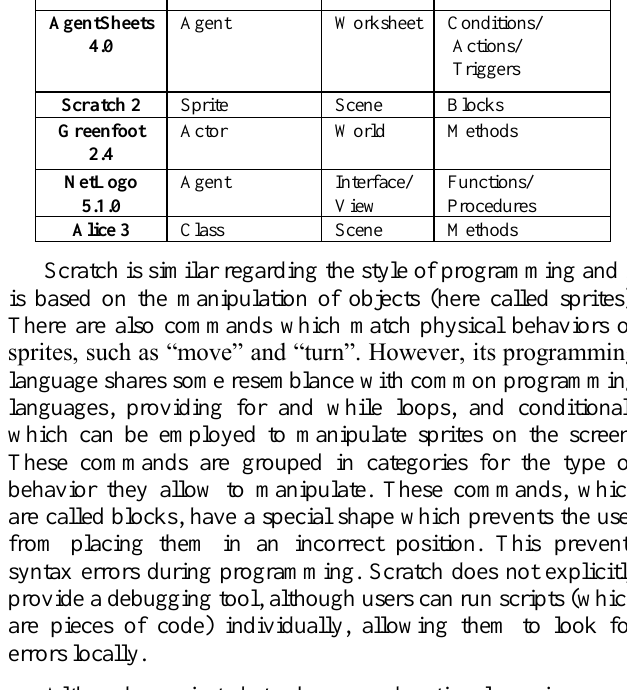
R ELATIONSHIP BETWEEN ELEMENTS OF CT TOOLS ANALYZED Programmable